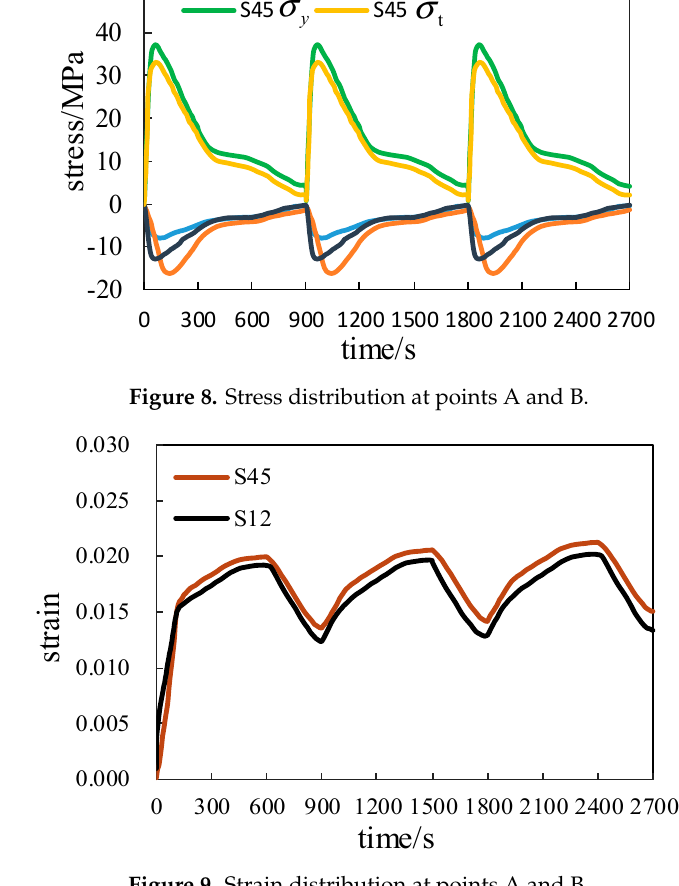
Figure 9. Strain distribution at points A and B.